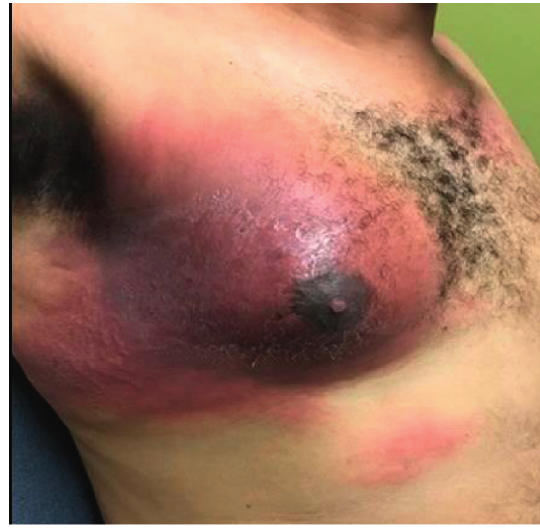
Figure 4: Erythematous skin lesion.